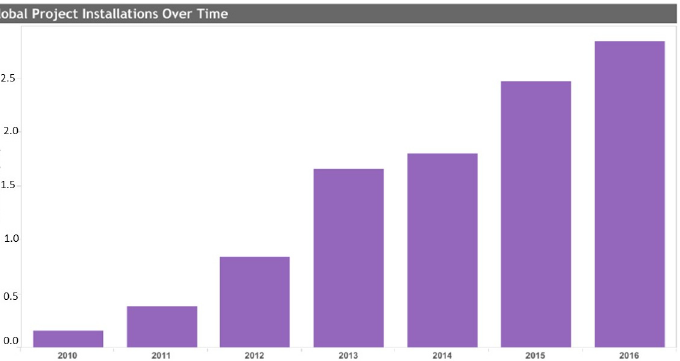
Figure 3. DOE Global energy storage database for all the European countries [74].